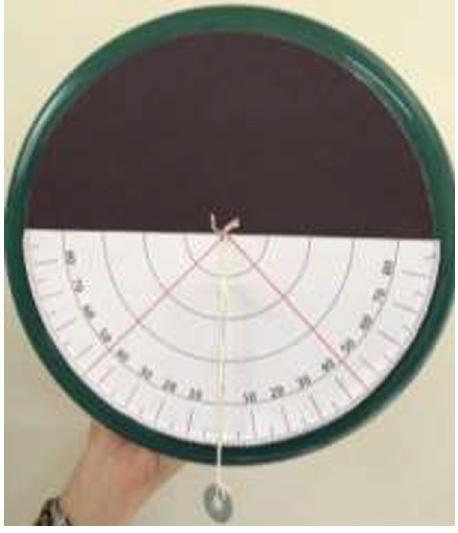
Figure 2 View of the outside and bottom of the